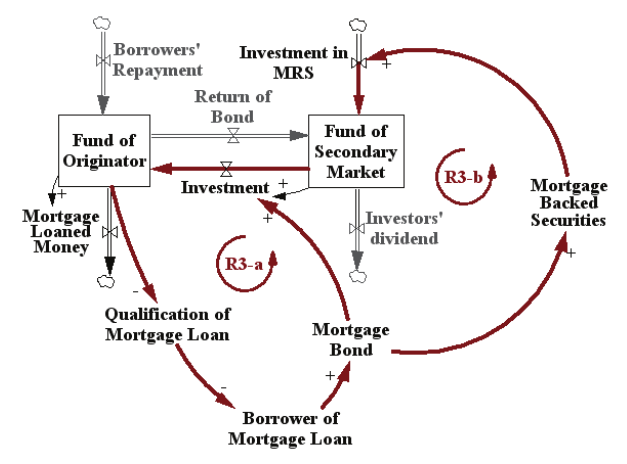
figure 6. investment in mortgage related